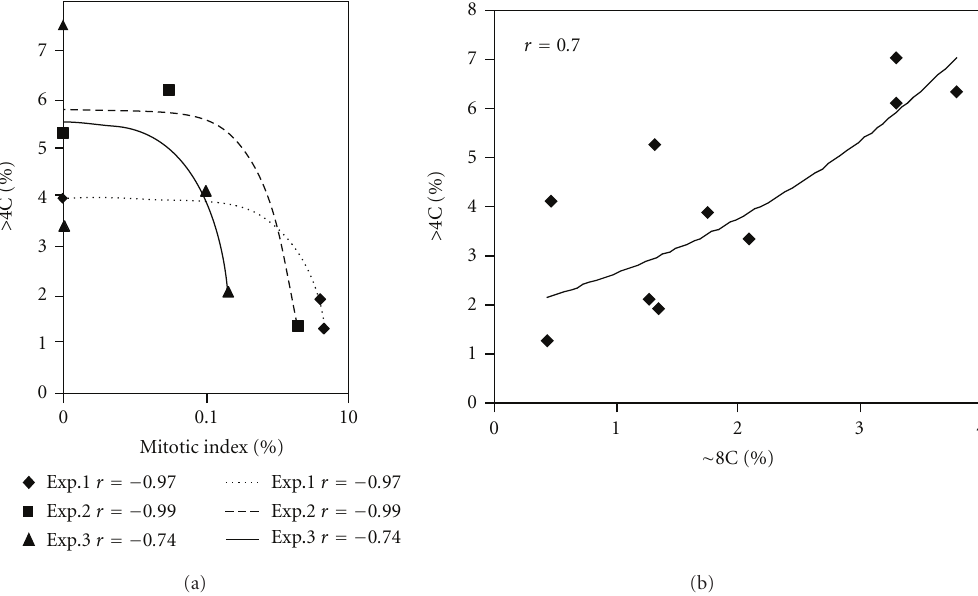
Figure 4: Tetraploidy increases in the course of IMR90 senescence. (a) The number of hypertetraploid cells increases with senescence and strongly inversely correlates with mitotic indices in each experimental series; (b) the number of cells with octoploid DNA content increases with hypertetraploidy indicating to increase of tetraploid cycling (the united data from three experiments).